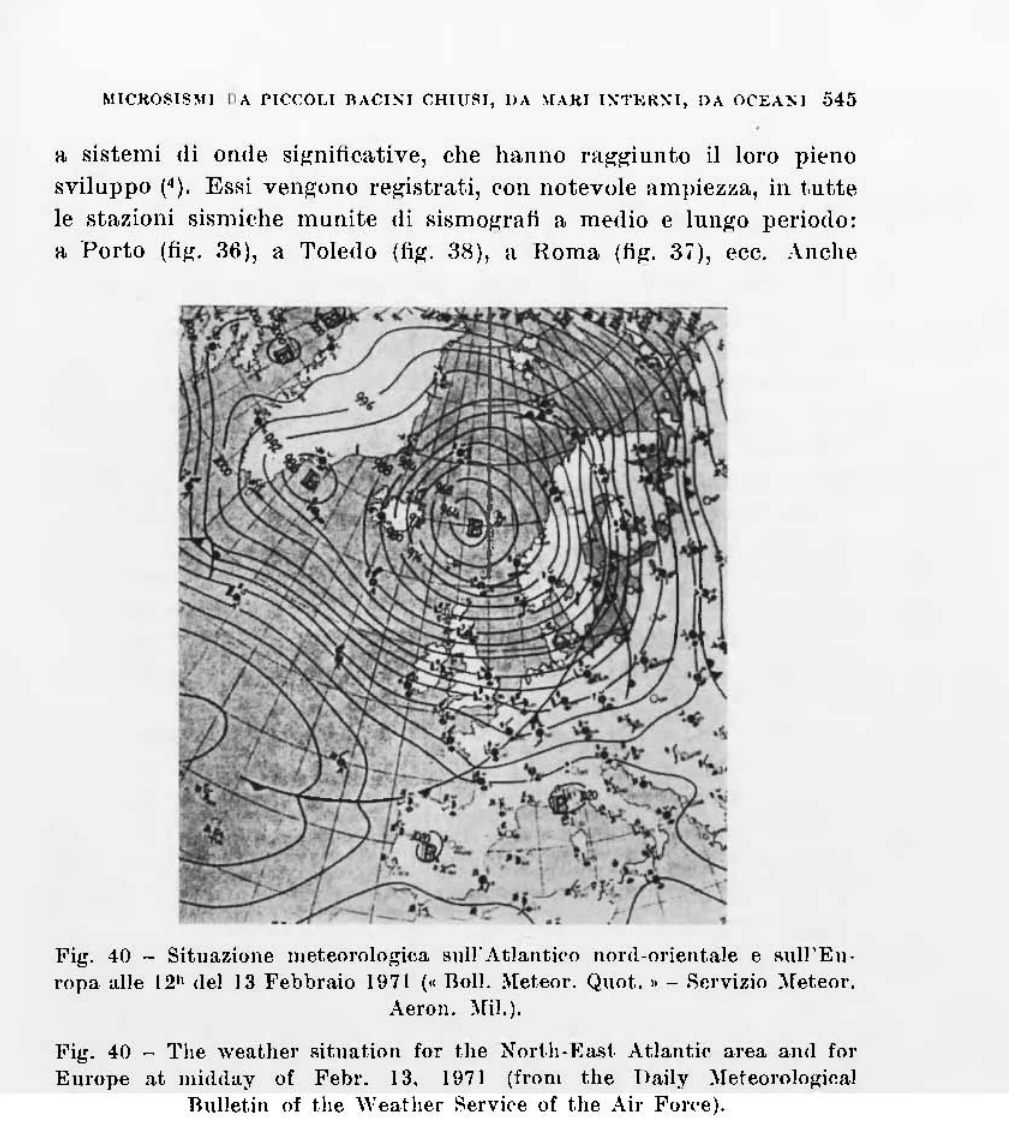
Fig, 40 _ Situaziune llleteol'Olog-ka HlllL\tlantko nord-orientale e !'.ull'Ell· l'Ora alle [211 Ilei 13 Febbraio 1U7[ (" nolI. "'[eteor, Quot, . - Rcrvizio ::'Ifeteor, Aeron, ::'Ifi!.), Fig. 40 _ l'he weather l\itllation for the Norl.h-~:a.st. Atlanti.' area allii for ElIrope at midday of Febl'. 13. 1U71 (front the llaily ::'Ireteol'Olo!{i~al Rulletin of the Weather Servire of the Air